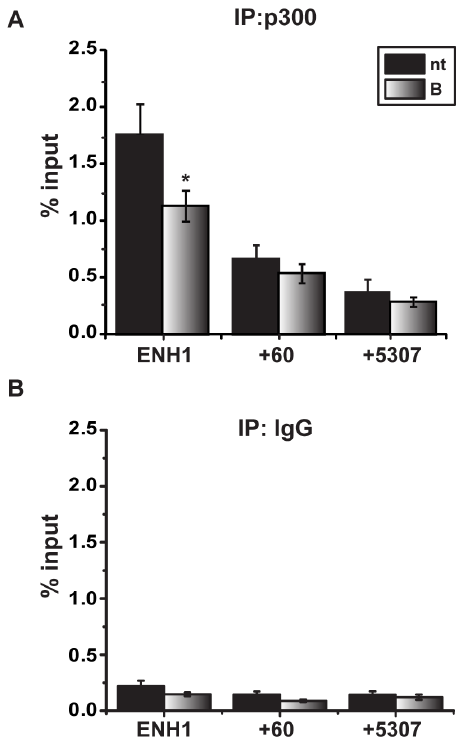
Figure 4. Proteasome inhibition decreases p300 occupancy on the ESR1 enhancer. MCF7 cells treated with vehicle (nt) or 30 nM bortezomib (B) for 24 hours and ChIP assays were performed to assess occupancy of p300 at the indicated region. Immunoprecipitation was performed using antibodies for A ) p300 and B ) IgG, as a control. Data are presented as percentage of the input sample. The data represent the average of a six independent experiments 6 SEM. Statistical analysis was performed to compare untreated and bortezomib-treated samples using a Student’s paired t-test. Statistically significant differences of p , .05 are indicated with an asterisk